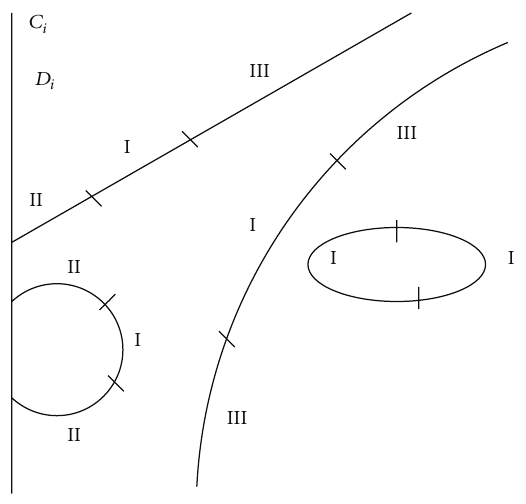
Figure 1: Type I, II, and III